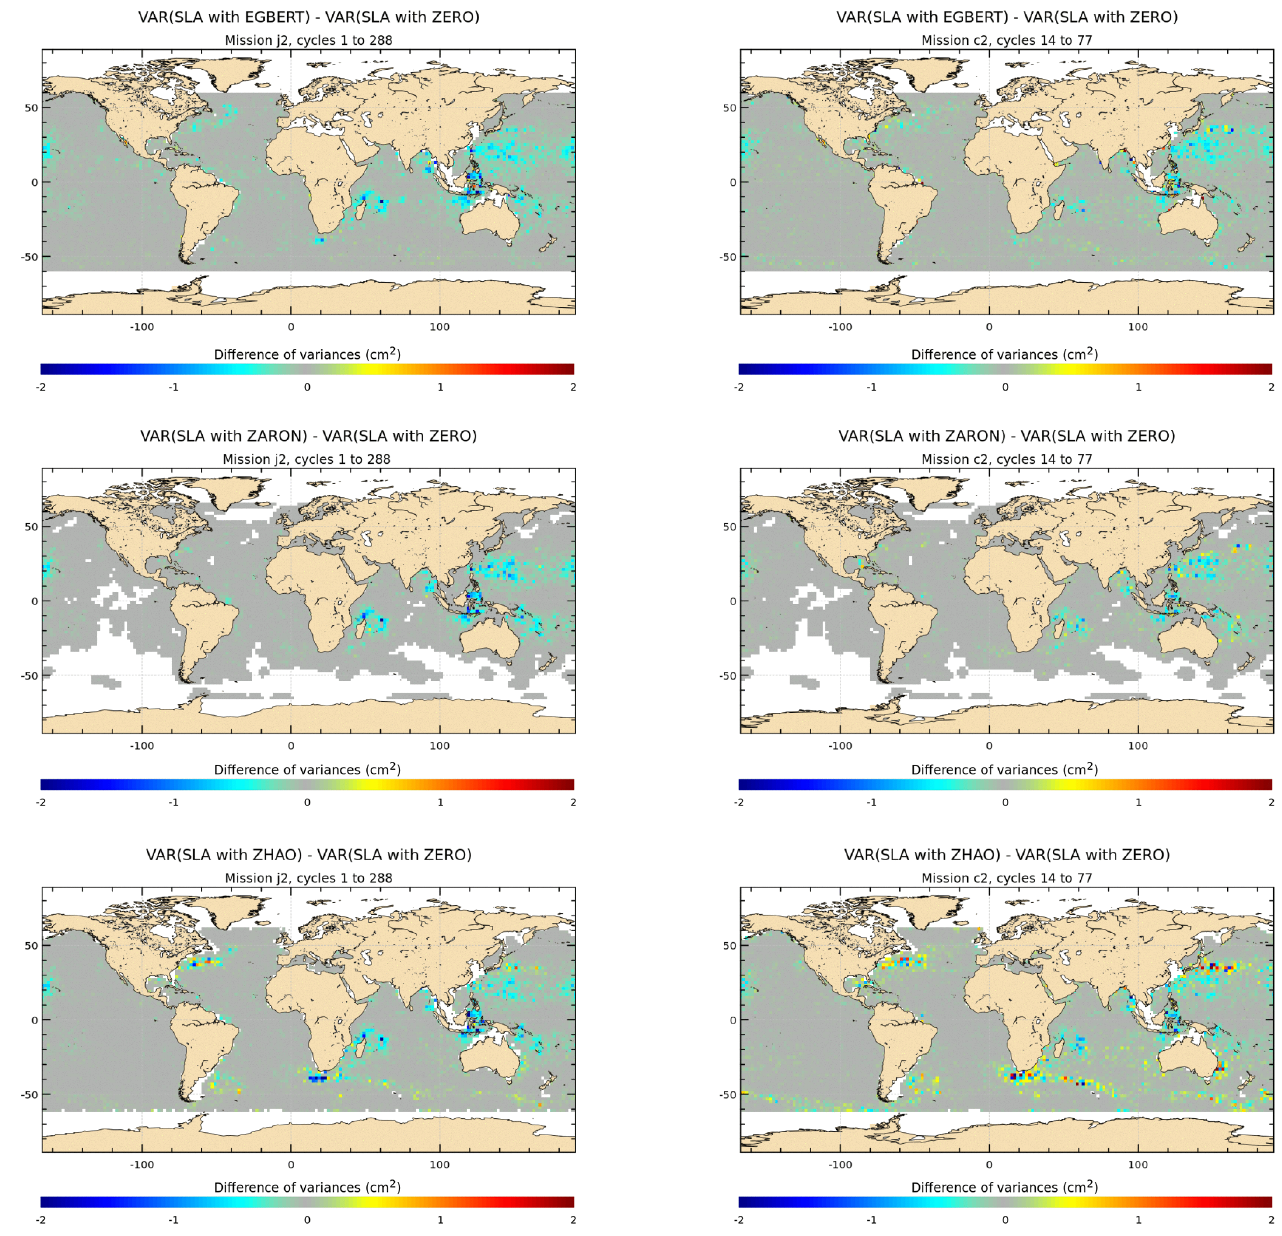
Figure C1. Maps of SLA variance differences using either the S 2 IT correction from each model or a reference ZERO correction in the SLA calculation for the J2 and C2 missions (cm 2 ). J2 cycles 1–288 have been used; C2 cycles 14–77 have been